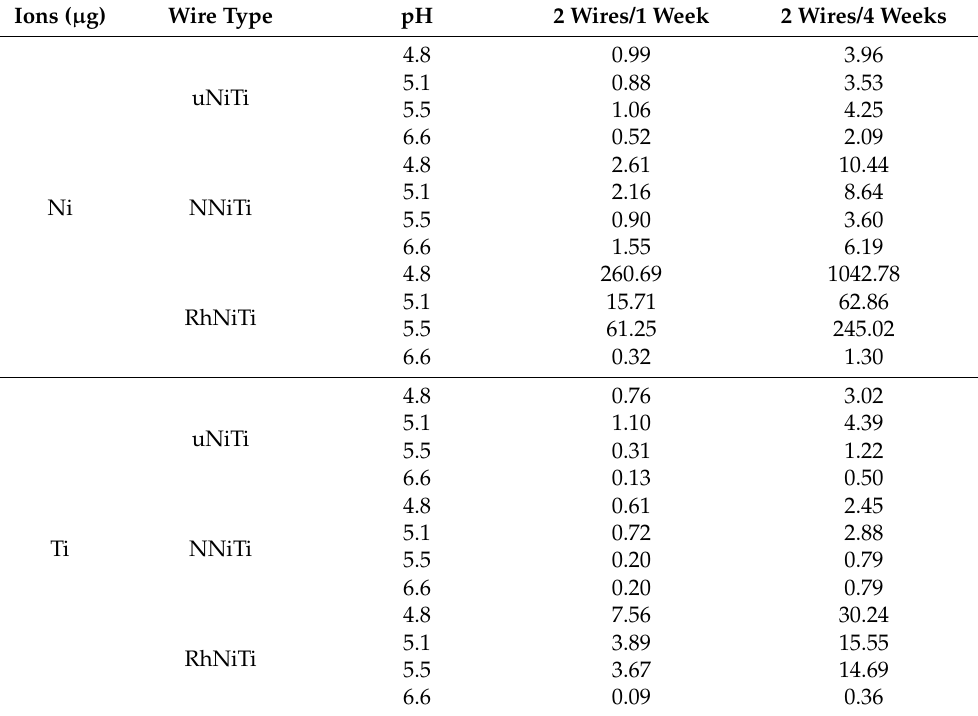
Table 3. Average release of nickel (Ni) and titanium (Ti) ions for a full mouth after one and four weeks of immersion in artificial saliva with pH of 4.8, 5.1, 5.5, and 6.6. Ions ( µ g) 2 Wires/1 Week 2 Wires/4 Weeks Wire Type pH 2 Wires/1 Week 2 Wires/4 Weeks